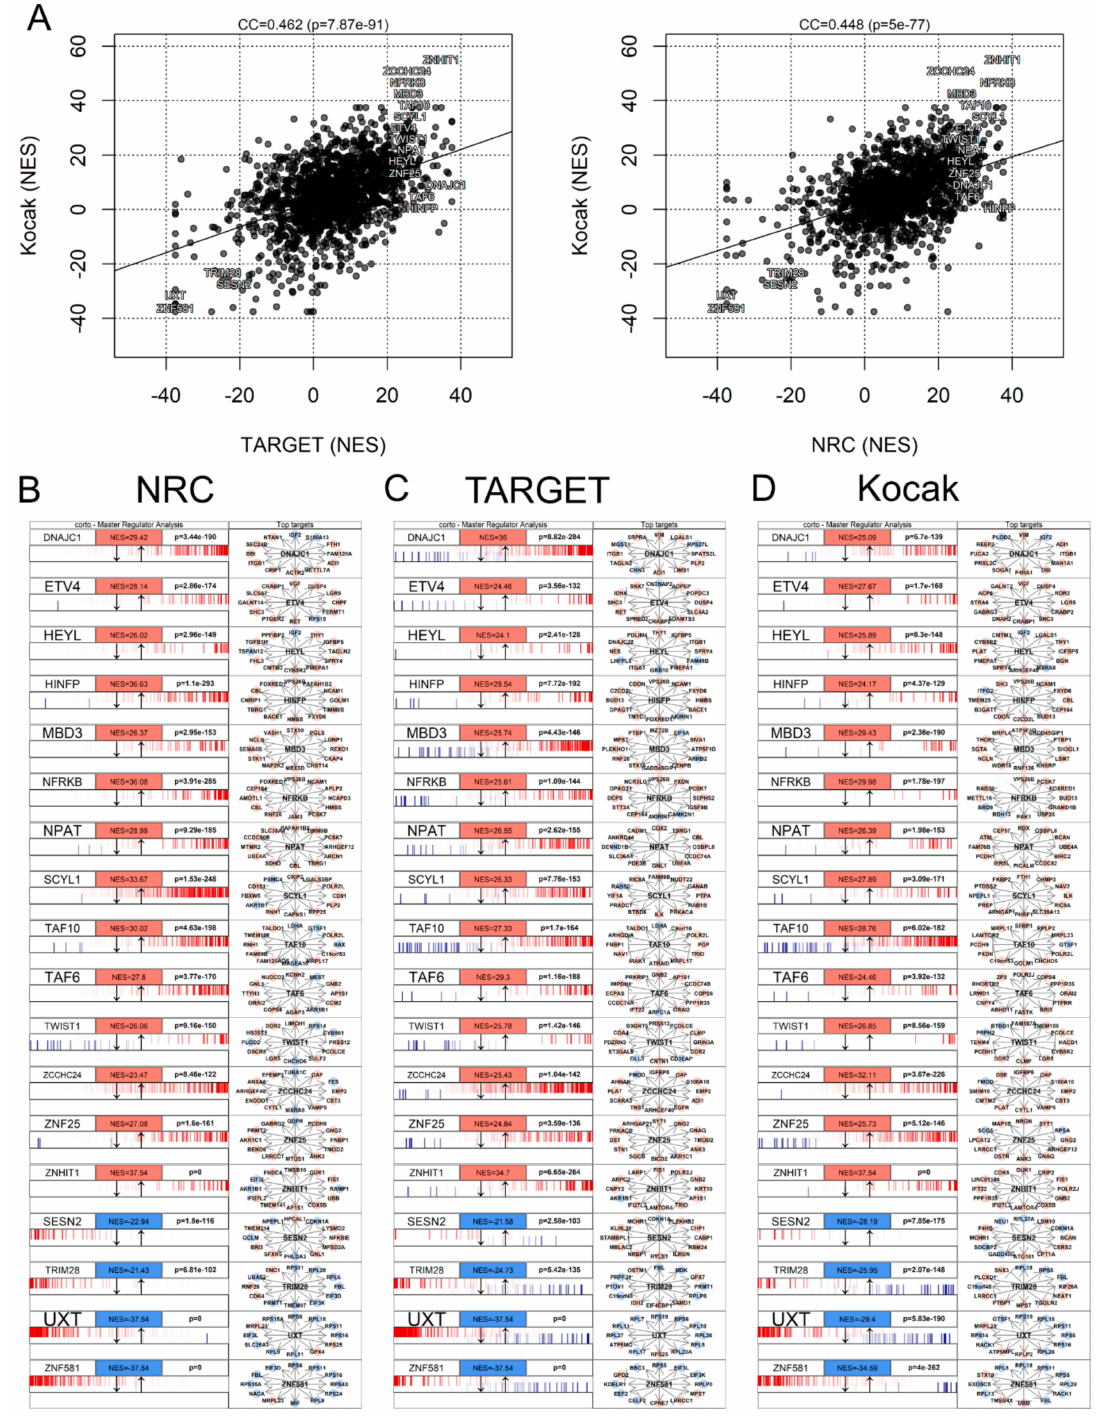
Figure 6. BE2C vs. Kelly master regulator analysis (MRA). ( A ) Comparison between MRA scores derived using the Kocak- based network ( y -axis) [52], and the networks derived from TARGET and NRC datasets ( x -axis) [22]. Master regulator scores, as plotted and defined by the corto R package [31] and expressed as NES, based on networks derived from ( B ) the Kocak dataset [52], ( C ) the TARGET dataset [22] and ( D ) the NRC dataset